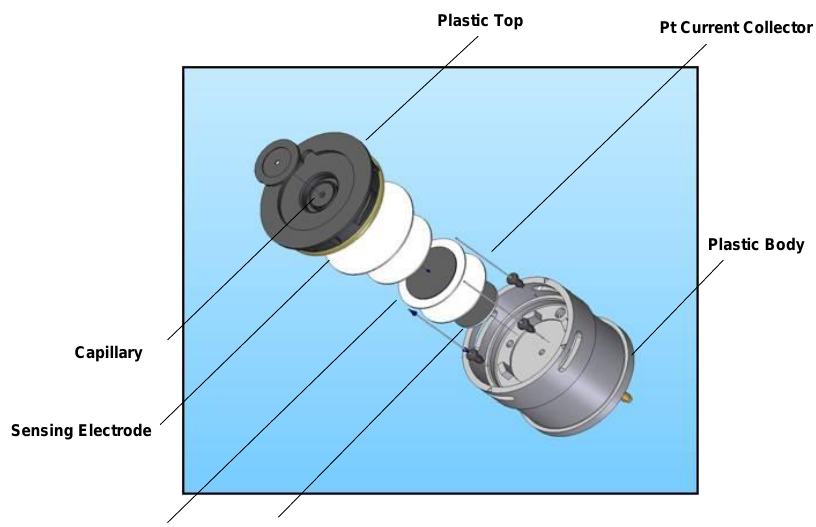
Figure 5. Early design for liquid electrolyte fuel-cell oxygen